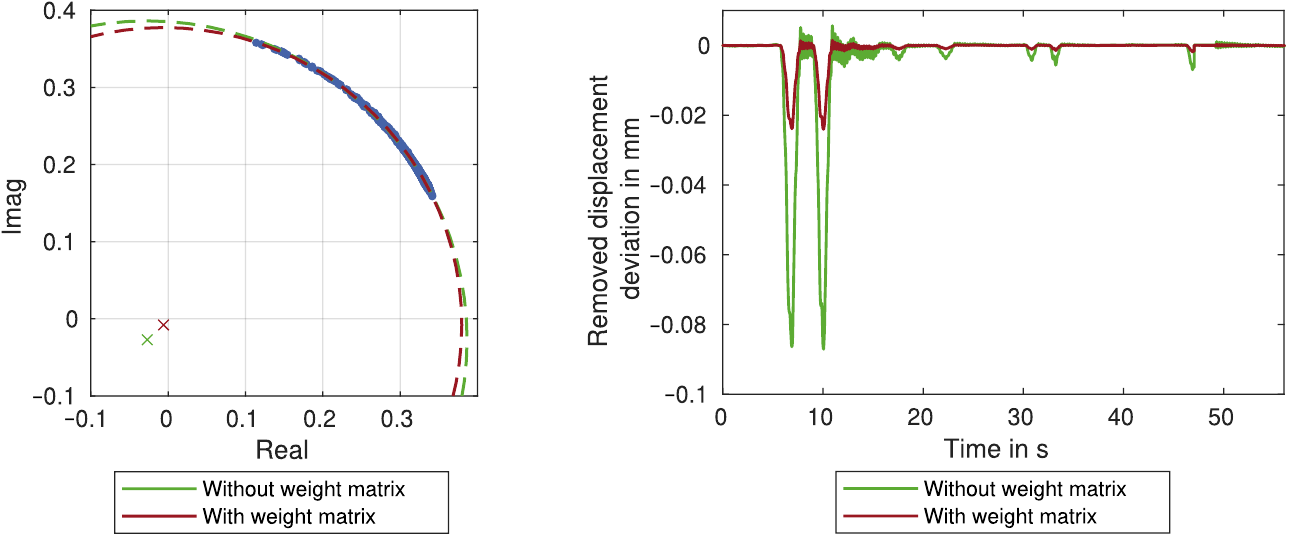
Figure 11. Clutter removal for a section of the LOS-displacements for Target 1 measured by GBR